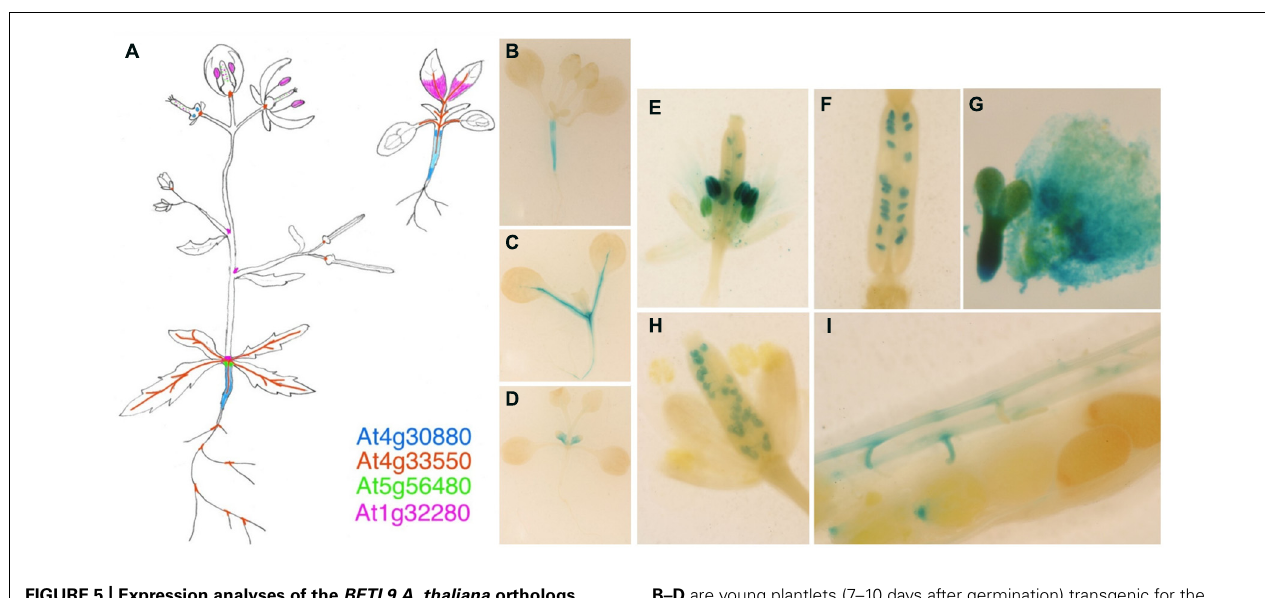
FIGURE 5 | Expression analyses of the BETL9 A. thaliana orthologs. Histochemical analyses for GUS expression in Arabidopsis thaliana transgenic plants. (A) Cartoon showing the expression pattern registered for the four promoters assayed, as indicated by the color code.The signal inside the ovaries and immature siliques corresponds to At5g56480 and At1g32280.